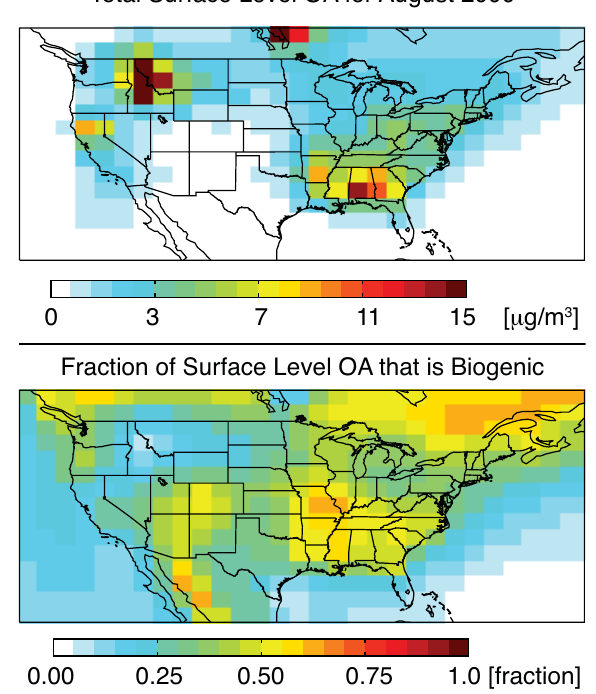
Fig. 5. Surface level organic aerosol from monoterpenes, sesquiter- penes, isoprene, benzene, toluene, xylene, and primary organic aerosol from a traditional, non-volatile POA simulation during Au- gust 2000. The biomass burning event near Idaho is saturated on the colorbar. Bottom panel is the fraction of aerosol in the top panel that comes from monoterpenes, sesquiterpenes, and isoprene. POA is assumed to be non-volatile and IVOCs do not form